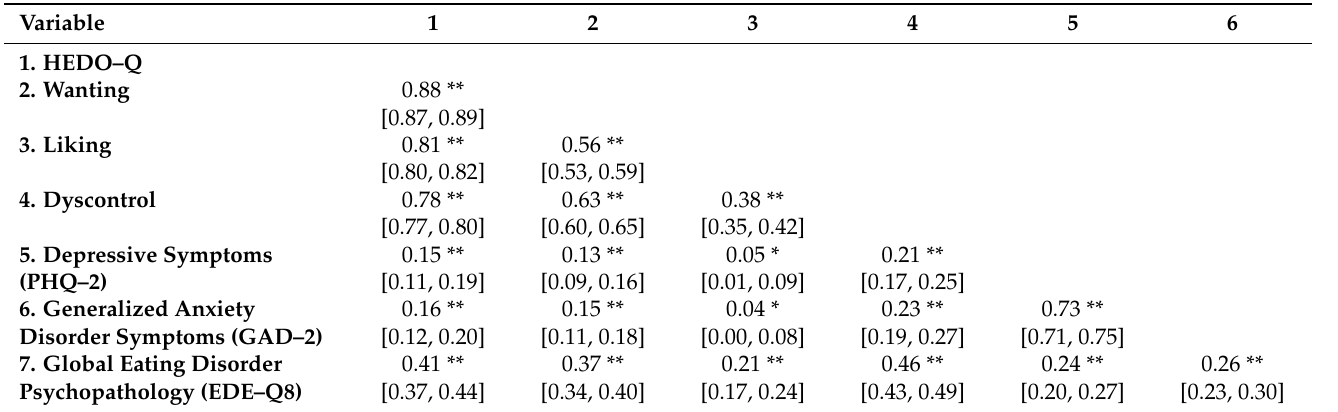
Table 6. Associations of the Hedonic Overeating–Questionnaire (HEDO–Q) with depression and generalized anxiety disorder symptoms and eating disorder psychopathology ( N =